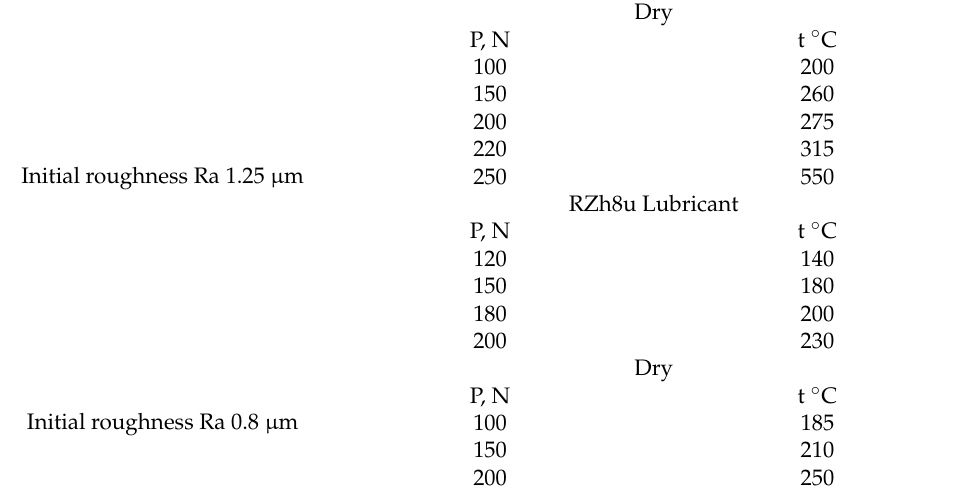
Table 4. Experiment results.